Question: Briefly state, in one sentence, what is plotted here.
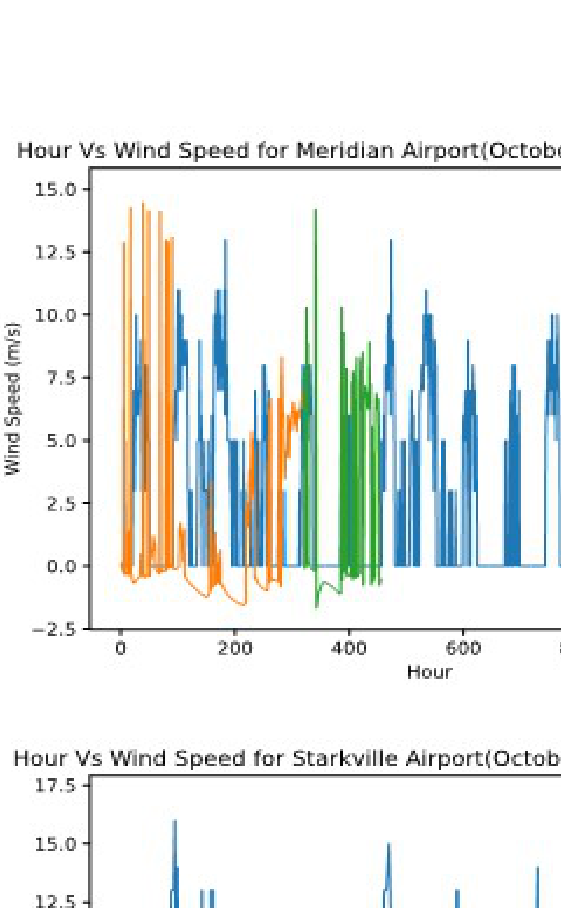
Answer: MERIDIAN VS. STARKVILLE FOR THE MONTH OF